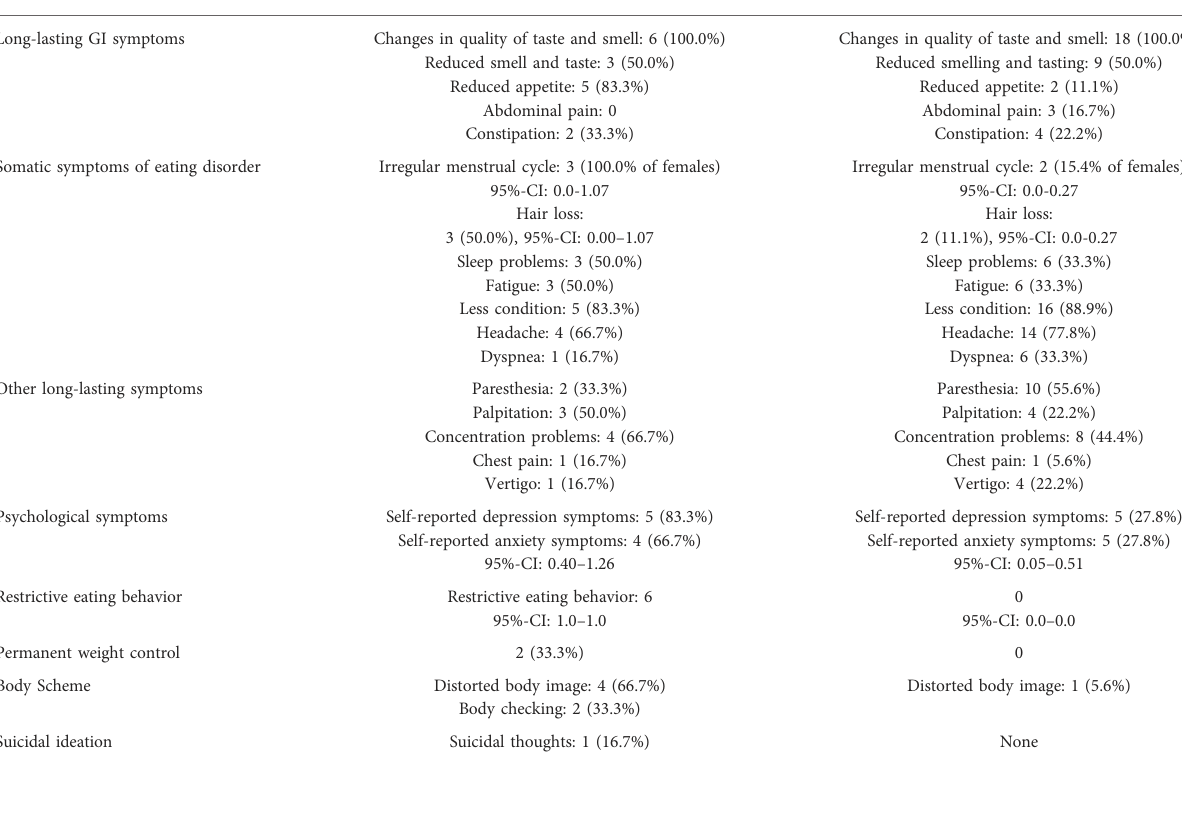
TABLE 4 Long COVID symptoms and eating